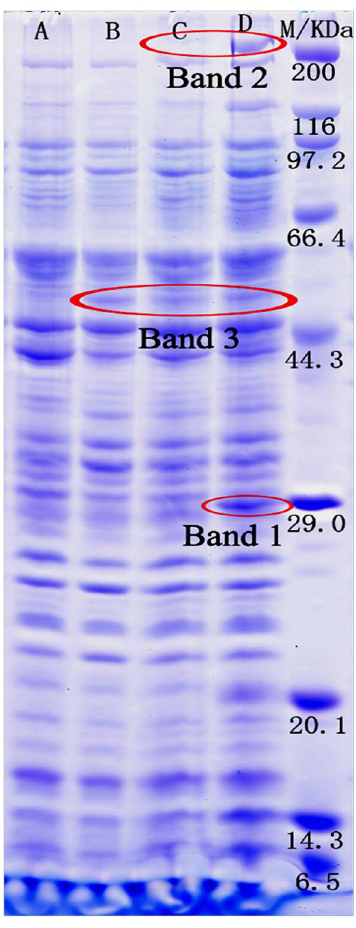
Figure 2. Separation of the total proteins of Novosphingobium pentaromativorans US6-1 using SDS-polyacrylamide gel electro- phoresis. M, marker; A, control; B, phenanthrene-induced; C, pyrene- induced; D, benzo[a]pyrene-induced.